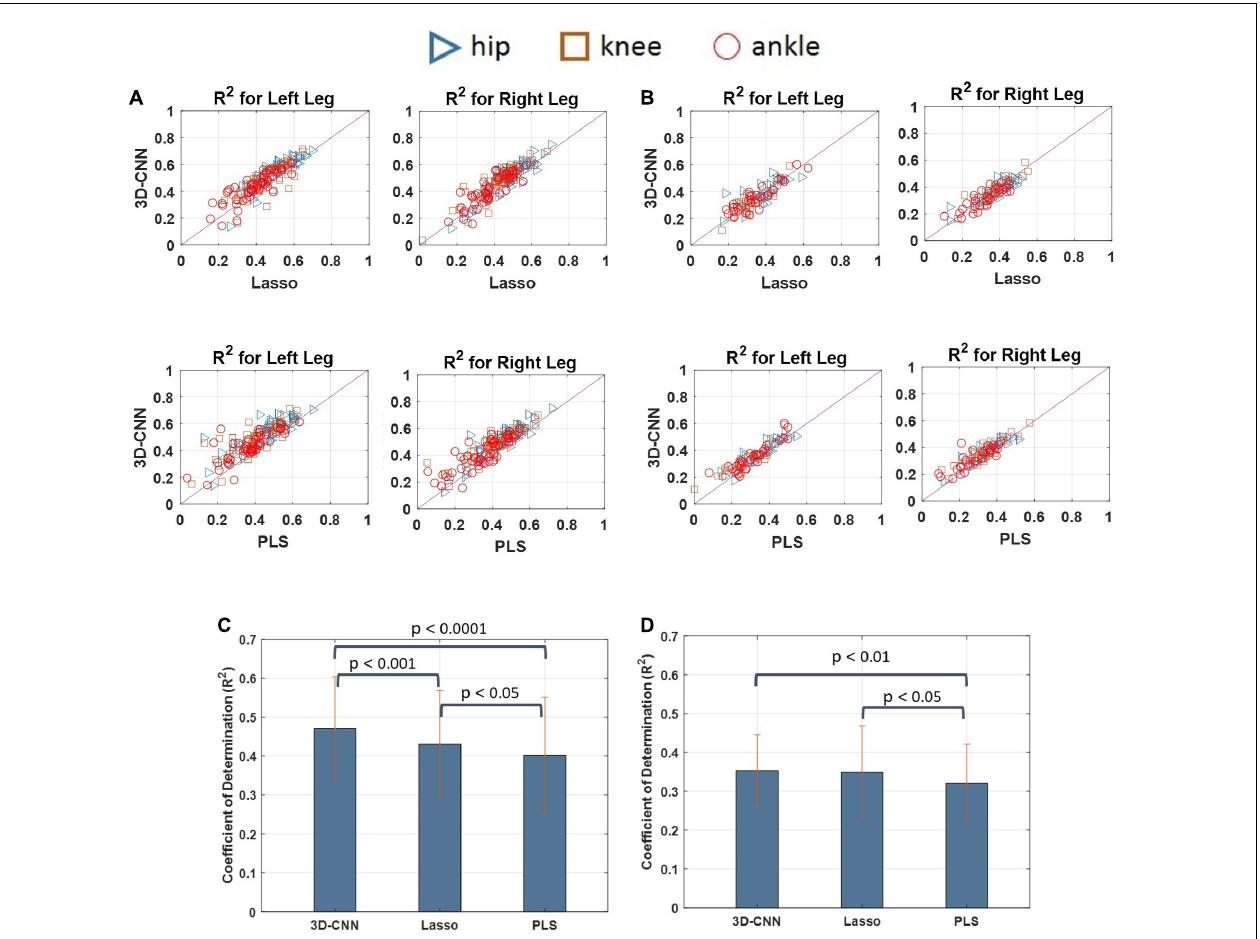
FIGURE 13 | Scatter plots comparing the decoding performances obtained by the 3D-CNN, Lasso, and PLS for cat 1 (A) and cat 2 (B) . Each point in the scatter plot represents the decoding performance obtained in one trial of experiment. The results over the diagonal line indicate that the method in y-axis (i.e., 3D-CNN) outperforms the method in x-axis (e.g., PLS or Lasso). Pairwise comparisons between the decoding performance obtained using different methods for cat 1 (C) and cat 2 (D) . The results show that the 3D-CNN yields higher decoding performance than the Lasso and PLS